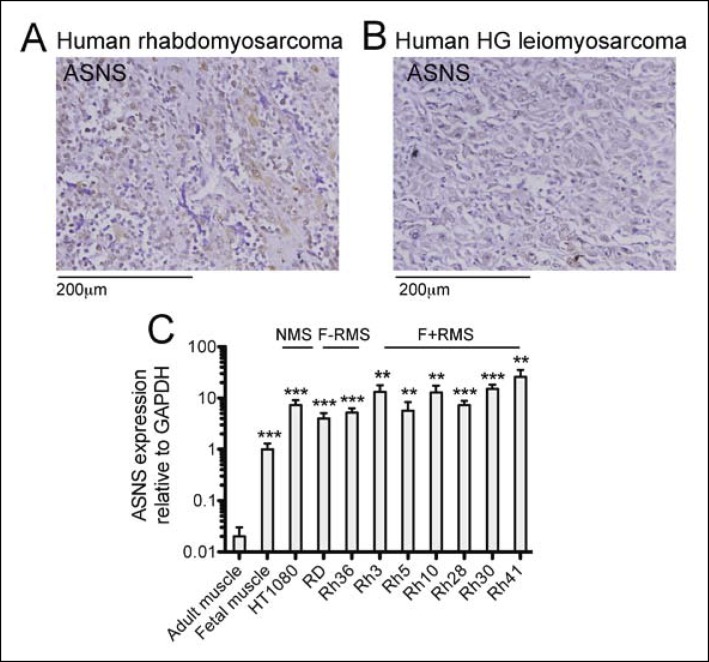
Expression of candidate sarcoma targets in human sarcoma tissue.(A-B) Immunohistochemical (IHC) staining of commercially available sarcoma tissue arrays (US Biomax SO2081) detected ASNS expression in (A) 73% of human RMS cores (22 tumors evaluated) and in (B) 44% of human leiomyosarcoma (LMS) cores (27 tumors evaluated). Representative stains are shown. (C) ASNS expression was detected in human sarcoma cell lines by qRT-PCR (ns p≥0.05, * p<0.05, ** p<0.01, *** p <0.001; as determined by T-tests compared to target gene expression in adult muscle).